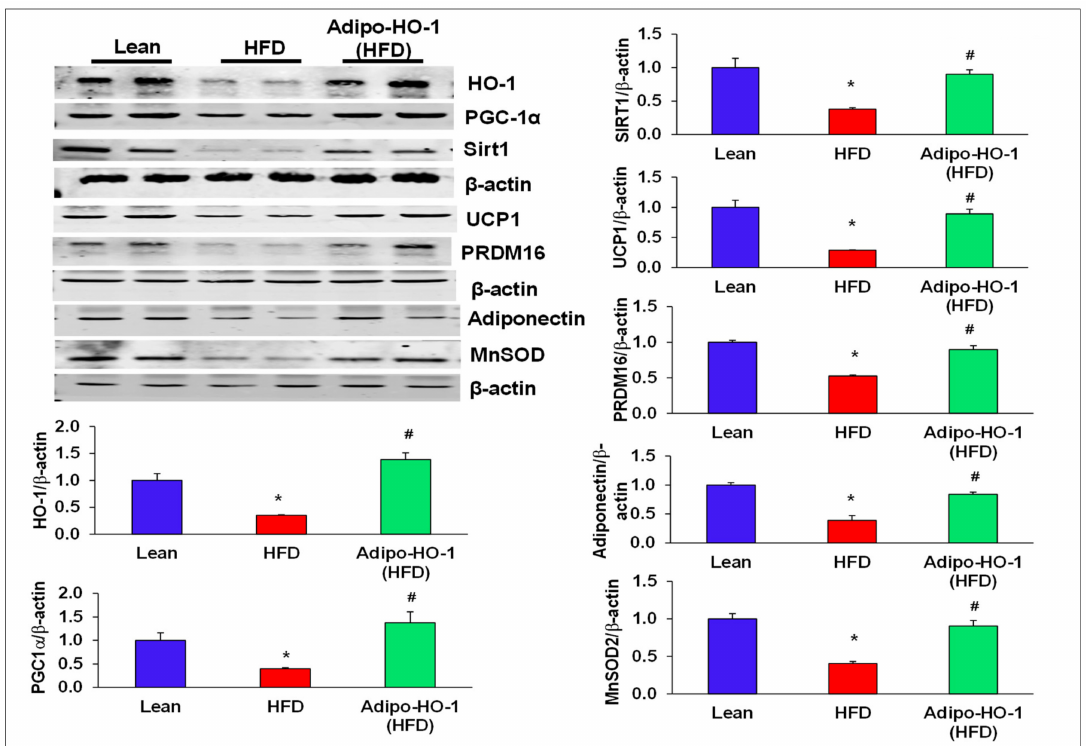
Figure 2. Lnv-adipo-HO-1 treatment mediated induction of key proteins involved in adipocyte metabolism. Representative Western blot analysis of HO-1, PGC-1 α , Sirt1, MnSOD, PRDM16, UCP-1, and MnSOD with their corresponding β -actin in adipose tissue of lean, HFD, and Lnv-adipo-HO-1 (HFD) mice; n = 5, * p < 0.05 versus lean; # p < 0.05 versus HFD alone. Uncoupling protein 1 (UCP1) was upregulated ( p < 0.05) in adipose tissues of mice